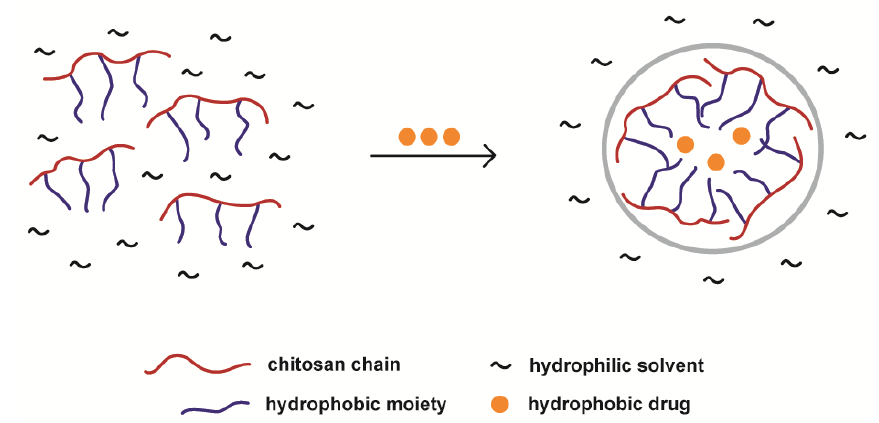
Figure 11. Schematic representation of hydrophobically modified chitosan self-assembly. Aggregates can entrap hydrophobic drugs in their hydrophobic core.